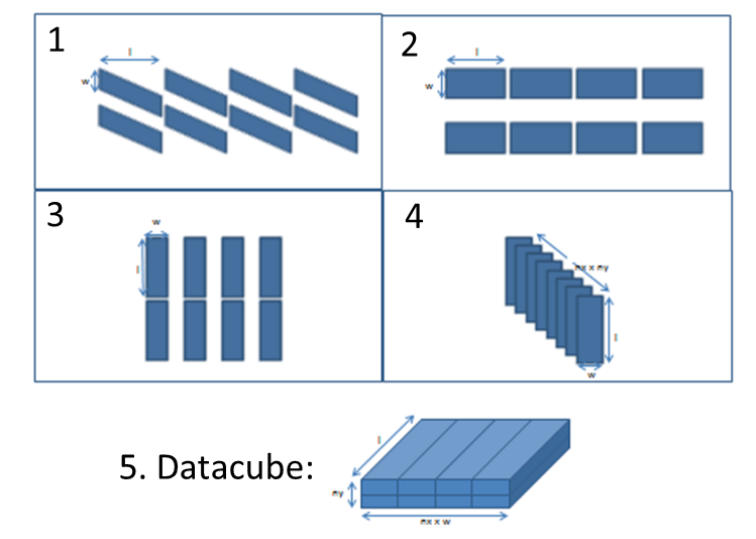
Figure 11. This figure shows the basic data manipulations required to convert the spectra obtained with the instrument into a 3D spectral datacube. Here w is the number of (spatial) CCD pixels along each slice (17 pixels), nx is the number of slices (19) along the length of the input image, ny is the number of slices across the input image (31) and l is the length of each spectrum (102 pixels only in this first